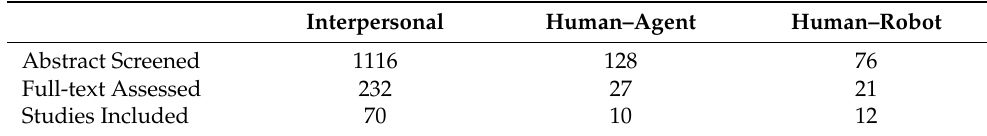
Table 1. The number of articles screened, assessed, and included for a review. Interpersonal Human–Agent